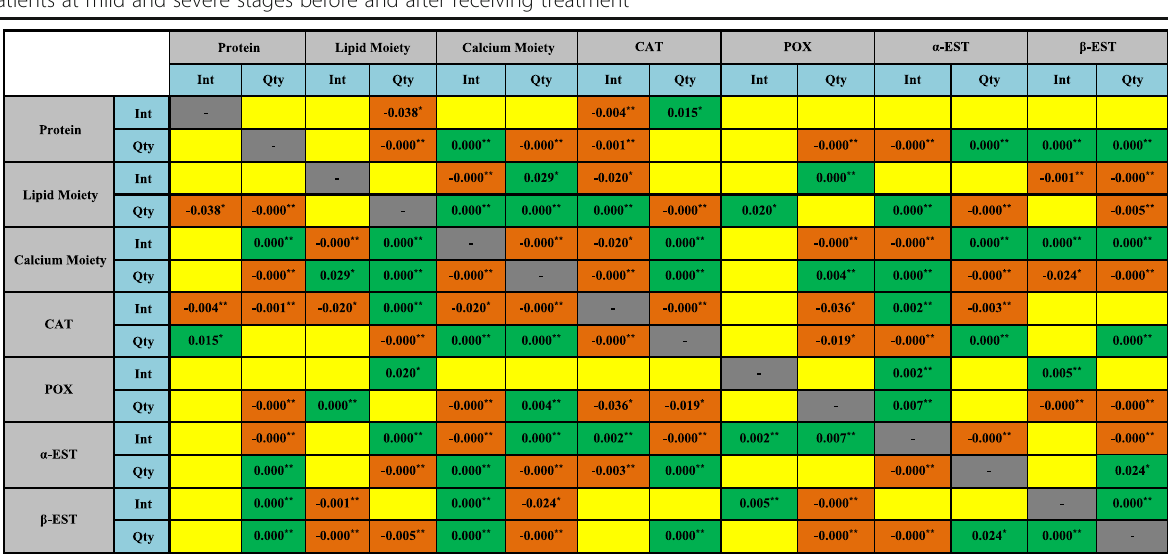
Table 3 Significant correlations among intensities and quantities of the native electrophoretic patterns in asthmatic bronchitis patients at mild and severe stages before and after receiving treatment